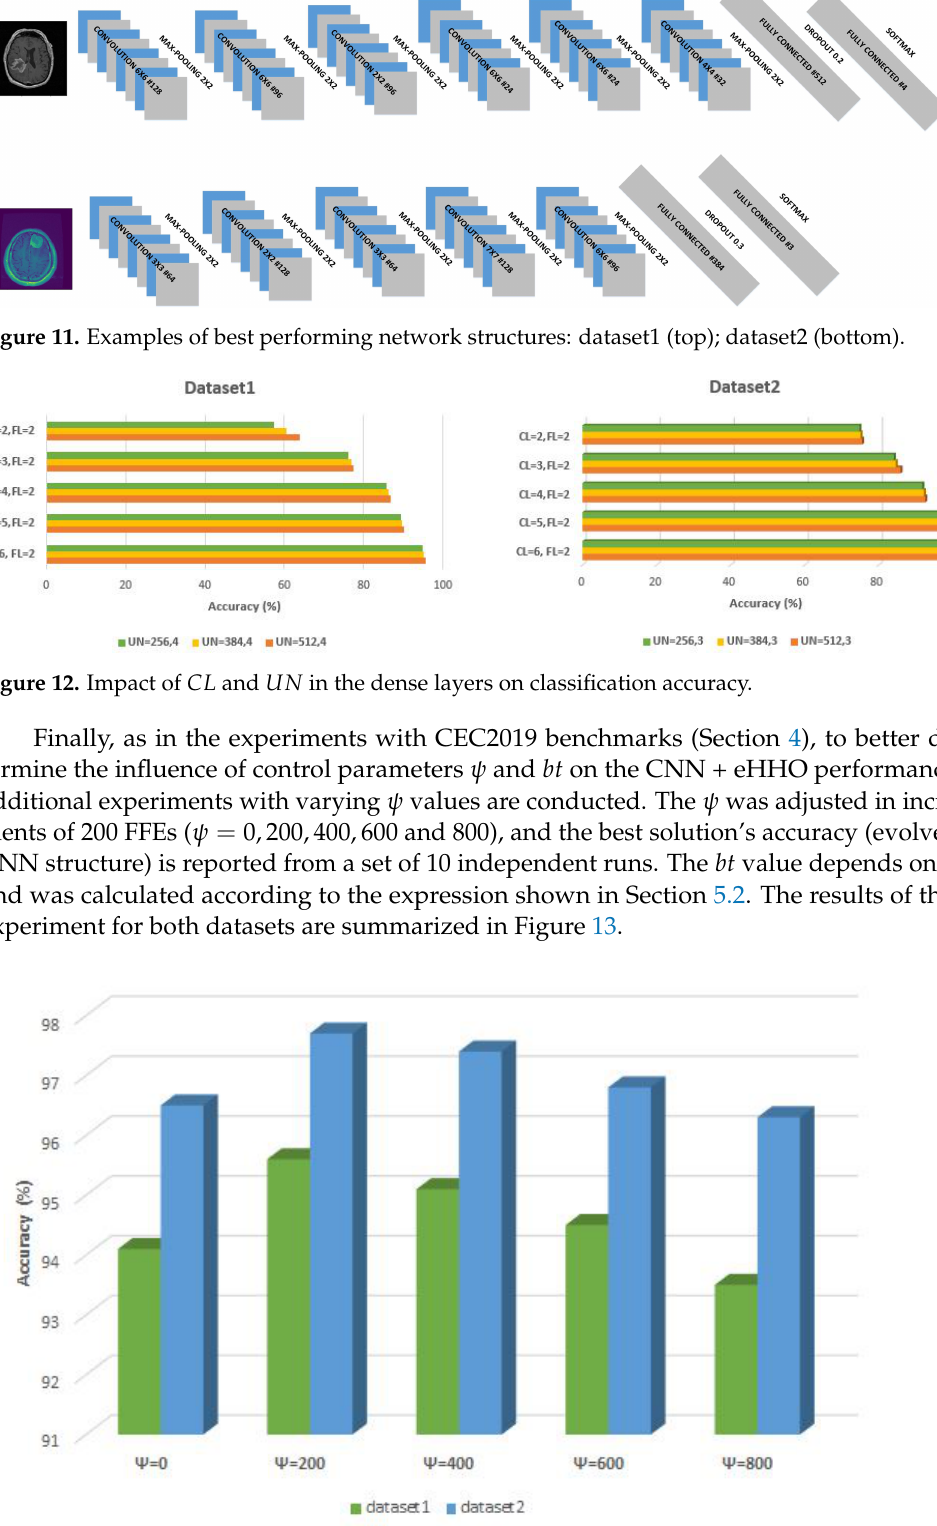
Figure 13. Effect of control parameter ψ on the CNN + eHHO